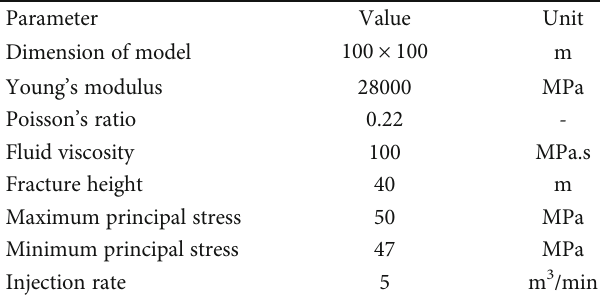
Table 2: Primary